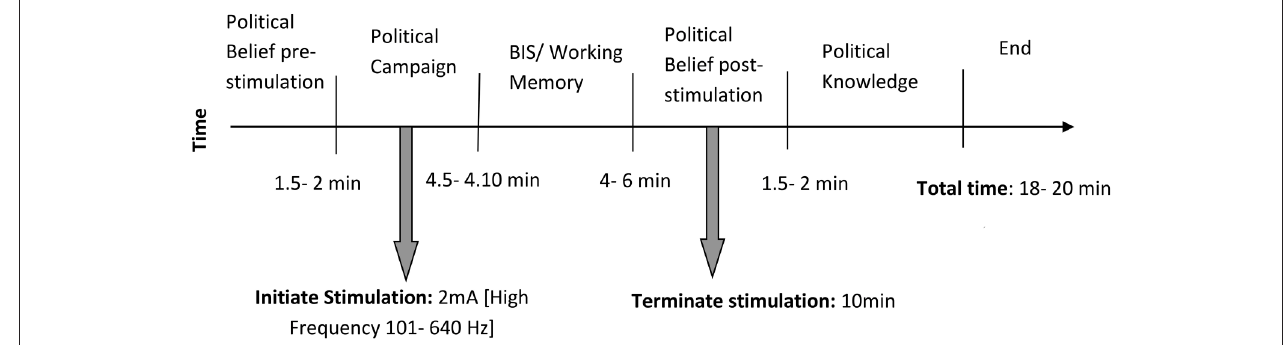
FIGURE 1 | Experimental Timeline (tRNS